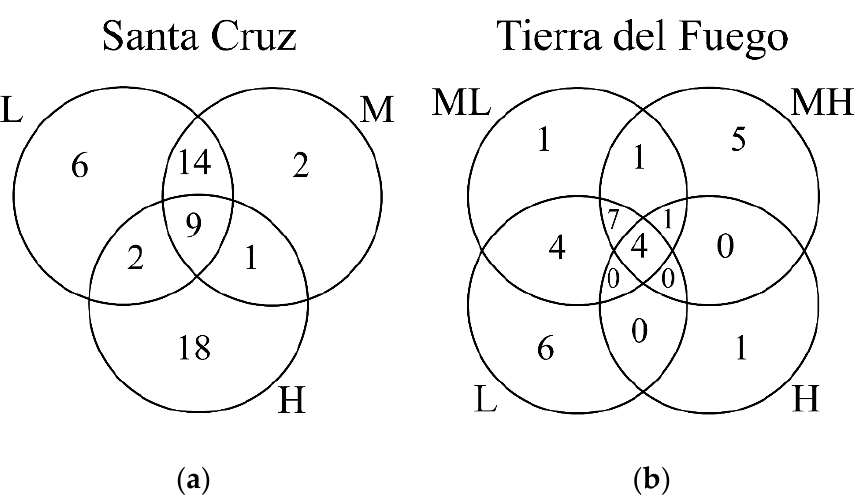
Figure 1. Overlapping graph of richness in the studied alpine vascular plant assemblages, including the entire survey information (baseline and re-sampling data), showing shared and exclusive species at different elevations (L = low, M = medium, ML = medium-low, MH = medium-high, H = high) in South Patagonia sites, immersed in ( a ) grassland landscape (Santa Cruz); and ( b ) forest landscape (Tierra del Fuego). Non-shown combinations (shared species only between ML and H, or between MH and L) have 0 species.